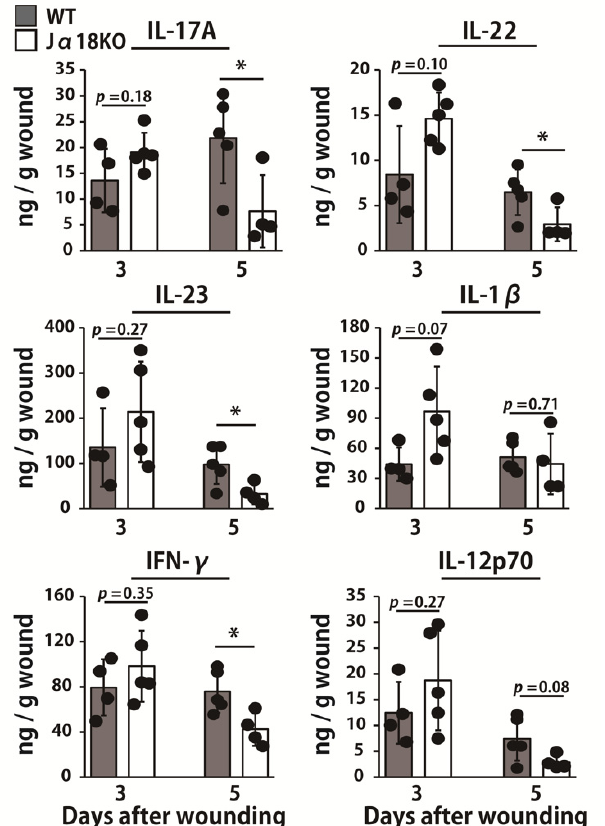
Figure 4. Effect of iNKT cell deficiency on the production of cytokines at the wound sites after inoculation with P. aeruginosa . WT and J α 18KO mice were wounded and inoculated with P. aeruginosa . IL-17A, IL-22, IL-23, IL-1 β , IFN- γ , and IL-12p70 levels in the wounded tissues were measured on days 3 and 5 (n = 4–5). Black circles represent one individual mouse. Each column represents the means ± SD. The results are representative of at least two independent experiments. * p < 0.05.